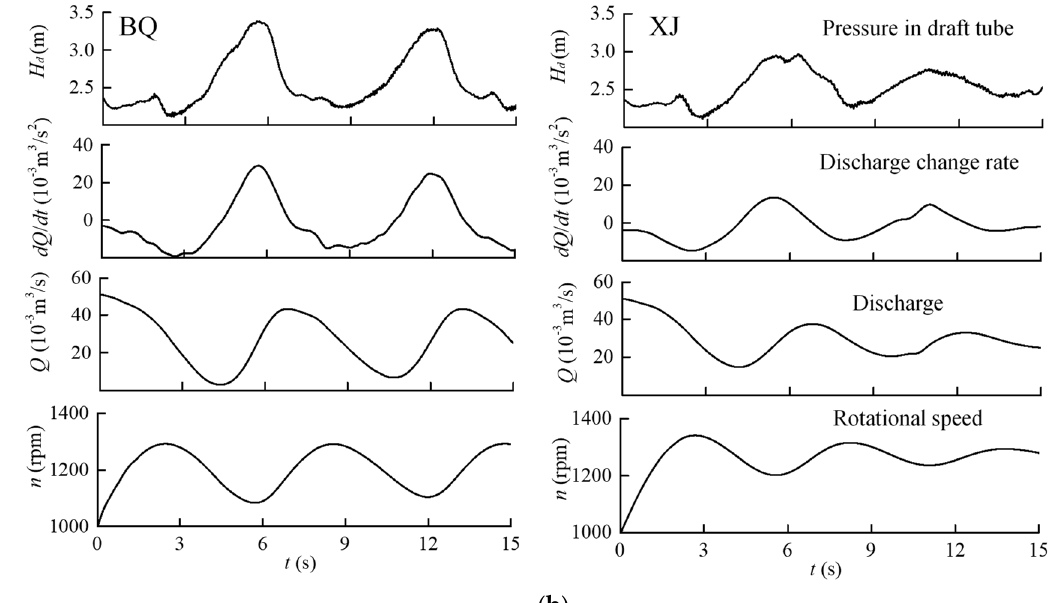
Figure 1. Different characterizations. ( a ) Runners. ( b ) Runaway oscillation processes [20].